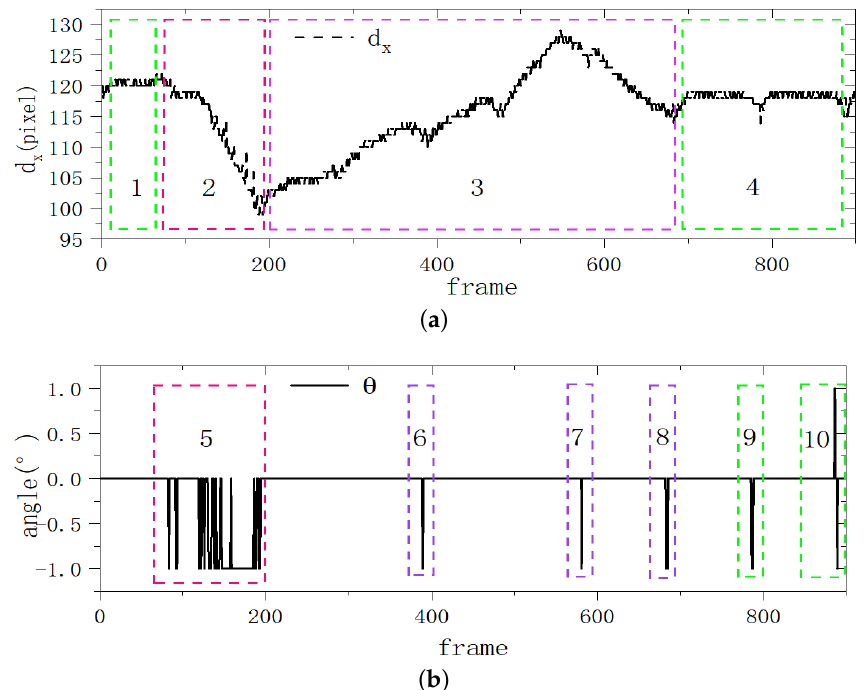
Figure 6. Image processing results using Method 1: ( a ) d x , the x-coordinate where the line intersects the X-axis, ( b ) θ , the angle between the line and the